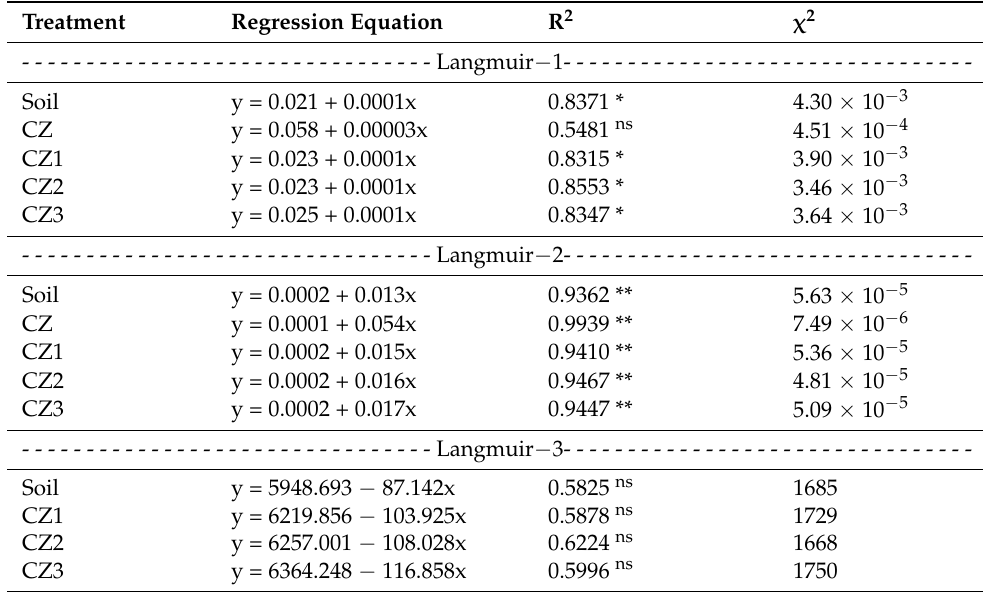
Table 15. Fitting Langmuir type 1, 2, and 3 isotherms to the phosphorus adsorption data based on simple regression and Chi-square analyses